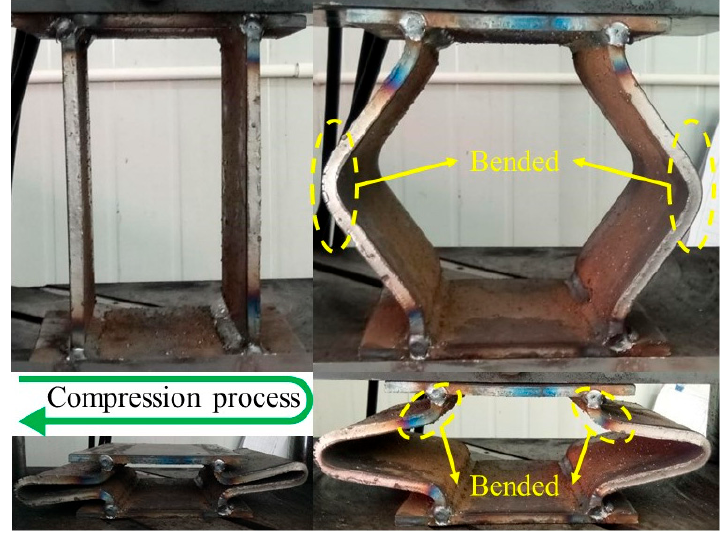
Figure 6. The compression–deformation process of the LED.